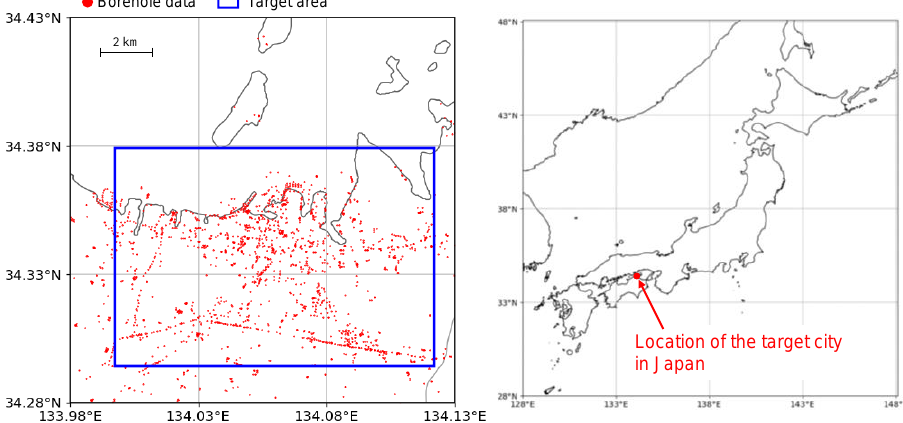
Figure 2. Target area (blue square area) and distribution of borehole data (red points).